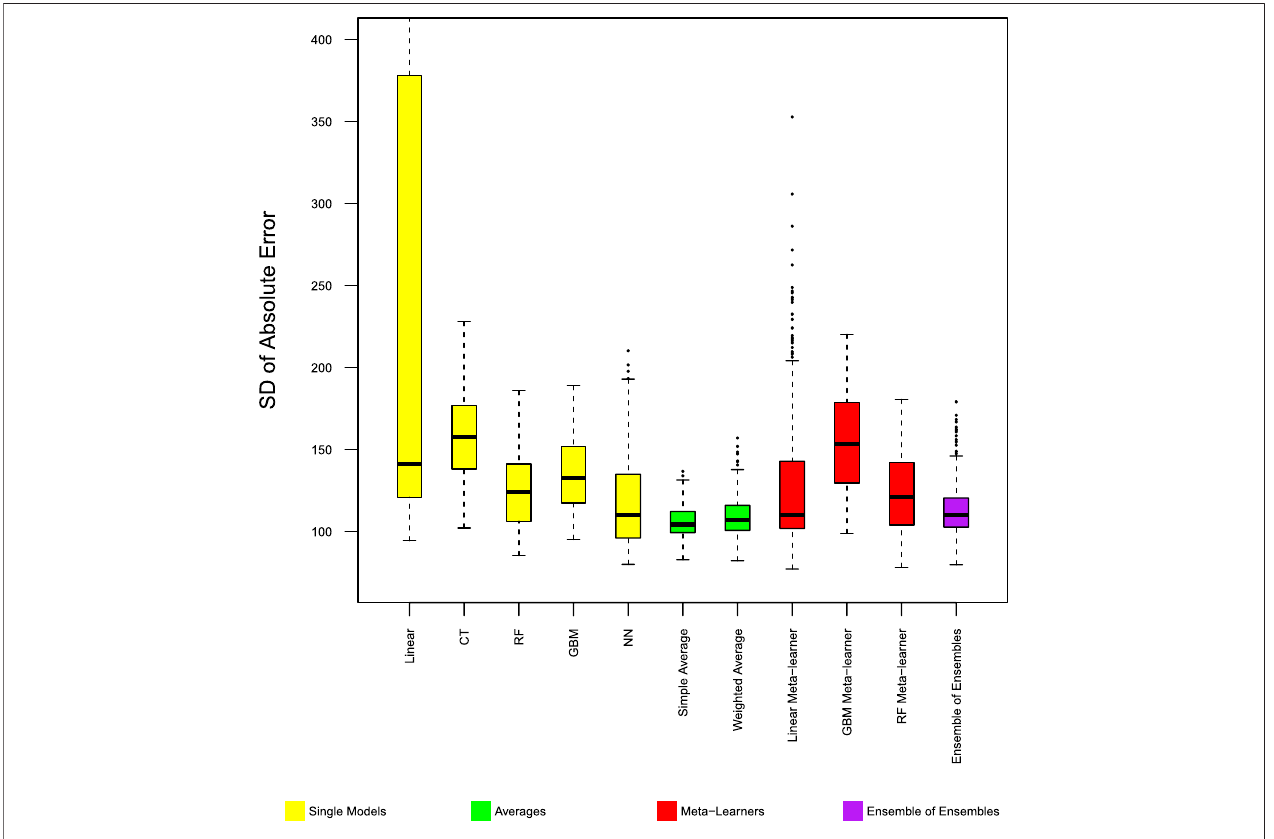
FIGURE 3 | Model performance in predicting trip production — Chicago SD absolute error. Distribution of standard deviation of absolute error from 400 experiments.